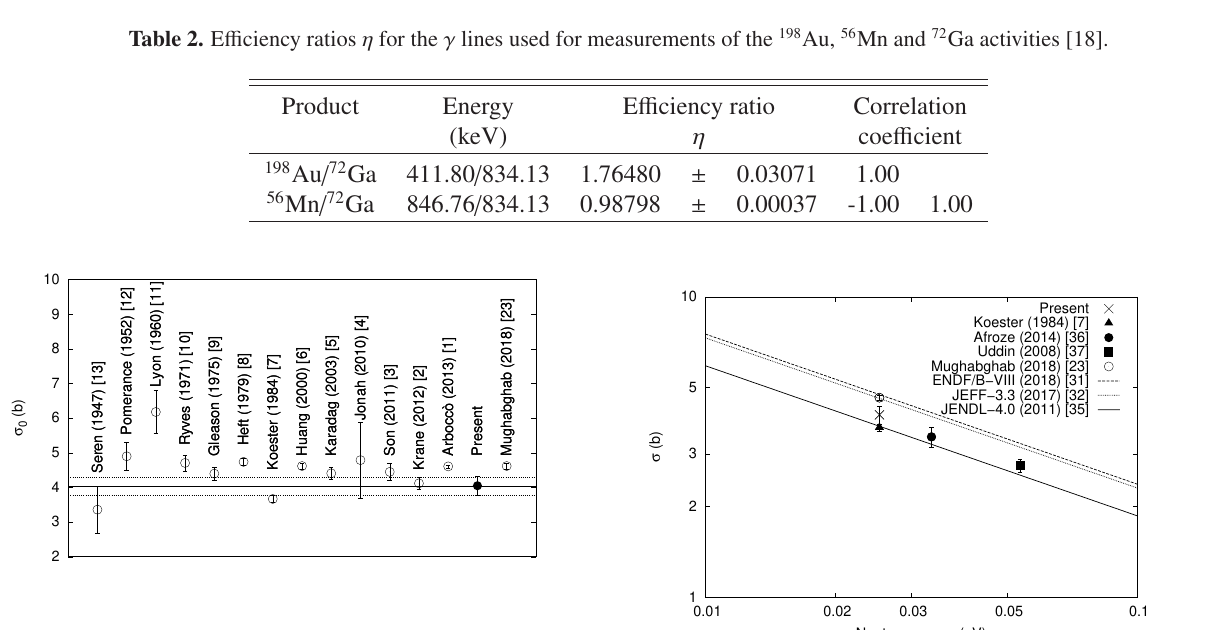
Figure 1. The thermal neutron cross sections of 71 Ga(n, γ ) 72 Ga reaction determined in our measurement (revised from Ref. [18]), other measurements [1–13], and Mughabghab’s recommendation [23]. Symbols are sorted by the chronological order on the horizontal axis. The solid and dashed lines show our result and its standard deviation, respectively.